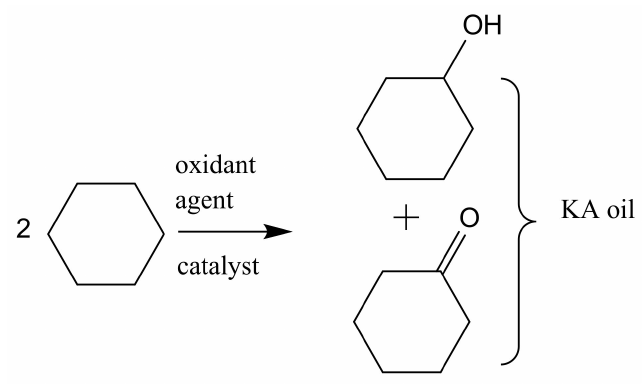
Figure 2. Oxidation of cyclohexane to cyclohexanol and cyclohexanone (KA